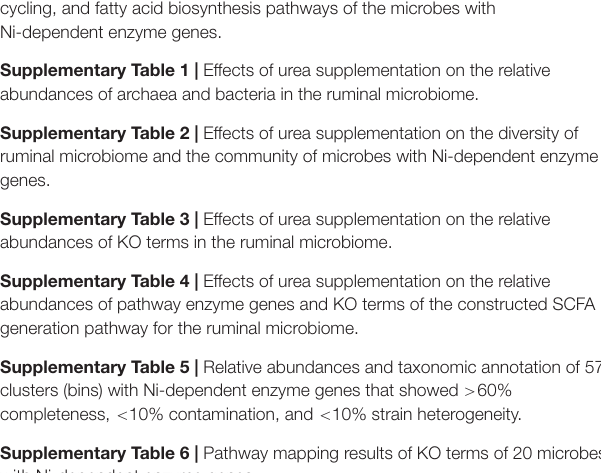
Supplementary Figure 3 | Schematic representation of sulfur cycling, nitrogen cycling, and fatty acid biosynthesis pathways of the microbes with Ni-dependent enzyme